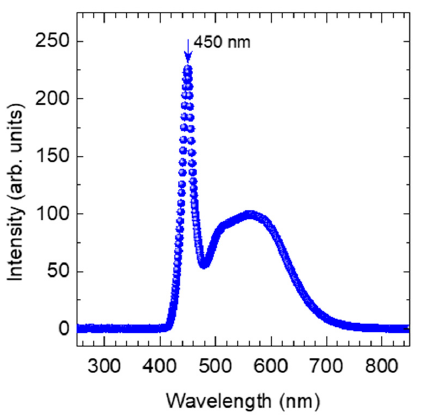
were measured after every 30 min of exposure, which were acquired using a Jenway’s 6800 double beam spectrophotometer (Cole-Parmer, Staffordshire, UK). The absorption peak at the wavelength of 472 nm in the UV-VIS spectra of RIF was used to evaluate the Figure 6. Schematic representation of the synthesis of ( a ) PS spheres, ( b ) IP-TiO 2 , and ( c ) Ag@IP-TiO 2 . Figure 6. Schematic representation of the synthesis of ( a ) PS spheres, ( b ) IP-TiO 2 , and ( c ) Ag@IP-TiO 2 . decrease in RIF concentration due to the photocatalytic